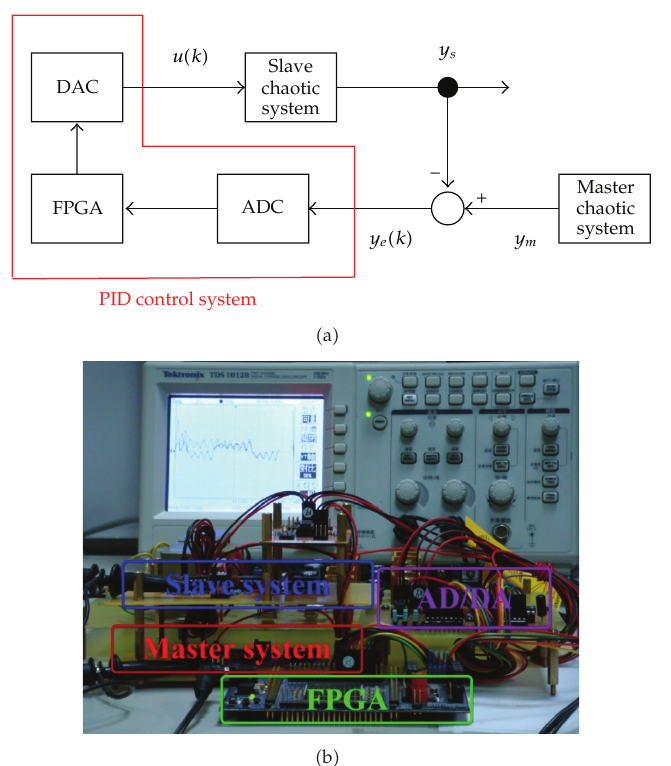
Figure 6: The Black diagram (cid:2) a (cid:3) and the photograph (cid:2) b (cid:3) of the proposed chaos synchronization